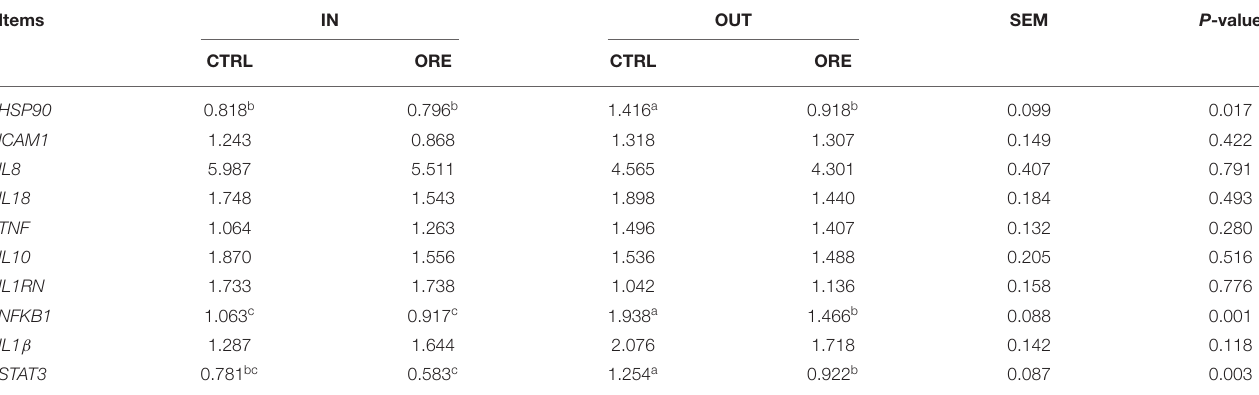
TABLE 6 | Rearing system and dietary treatment interaction effects on gene expression.